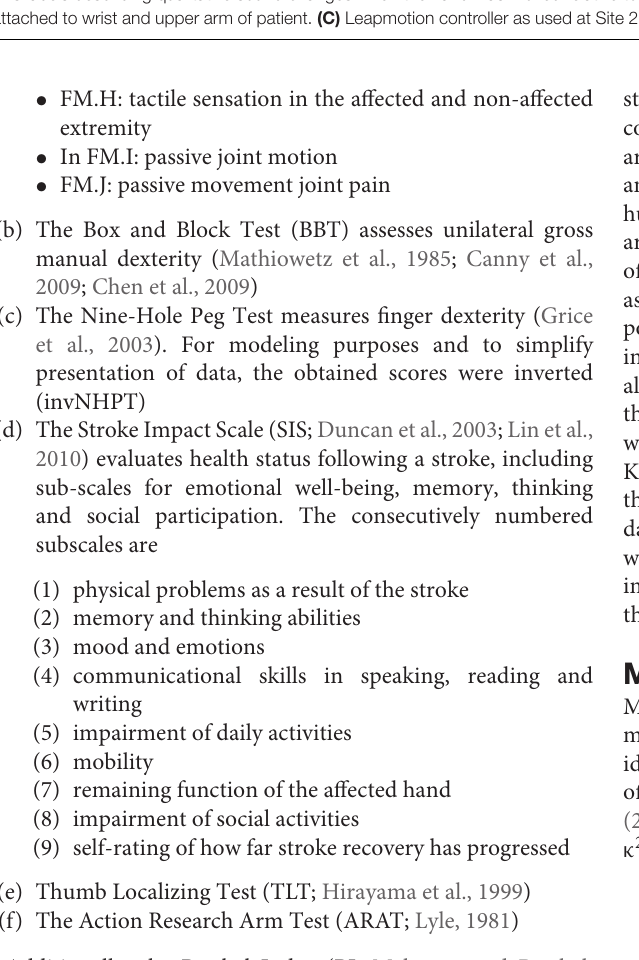
FIGURE 2 | Experimental setup. (A) three-dimensional space (the Leapmotion controller at Site 2 was placed on the board at the position marked in purple), with axis labels describing qualitative sound changes when the hand was moved relative to the frame (and hence, the body). (B) Xsens sensors as used at Site 1, attached to wrist and upper arm of patient. (C) Leapmotion controller as used at Site 2, with the space axes superimposed. Panel (A) taken from Scholz et al.